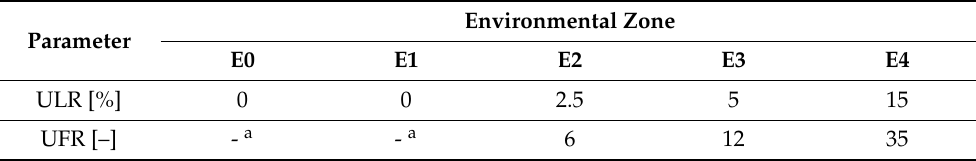
Table 1. ULR and UFR criteria values in environmental zone for amenity lighting [43].